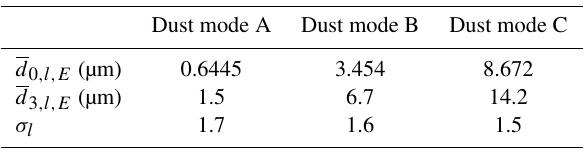
Table 2. Parameters for the log-normally distributed mineral dust. d 0 ,l,E ( d 3 ,l,E ) is the median diameter of the specific number (mass) emission of mode l . The SD of mode l , σ l , is held constant for the whole